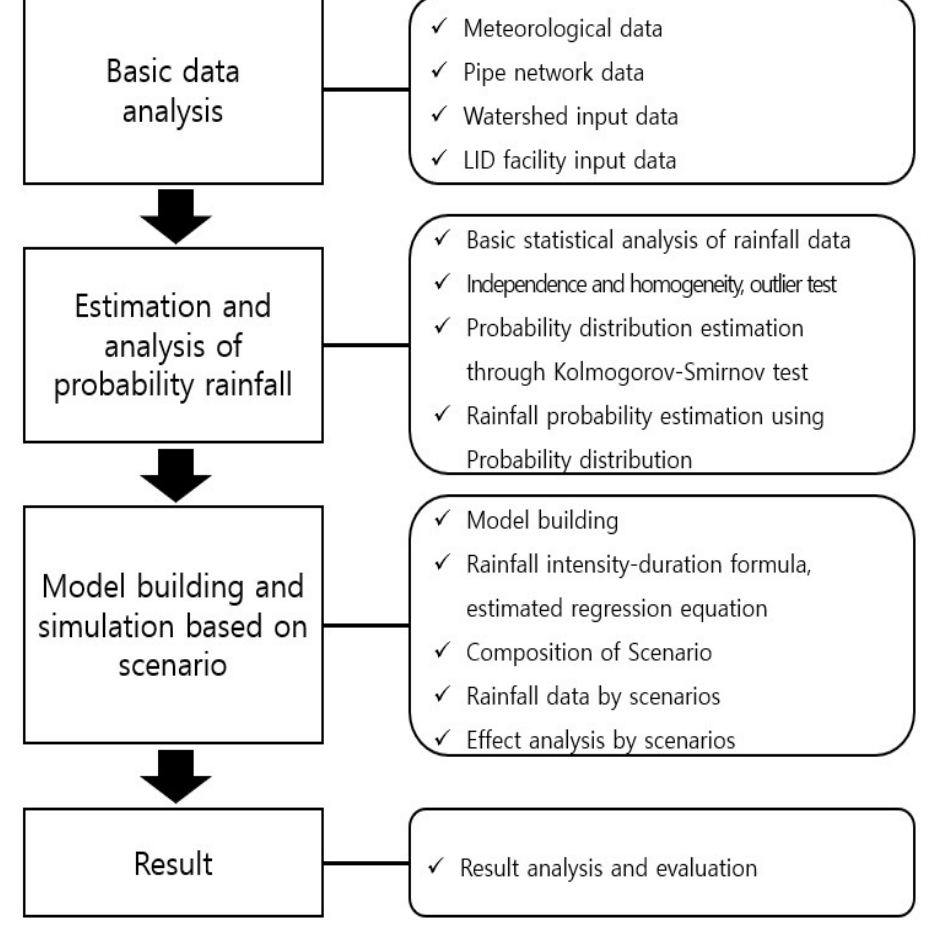
Figure 6. Study flow chart.